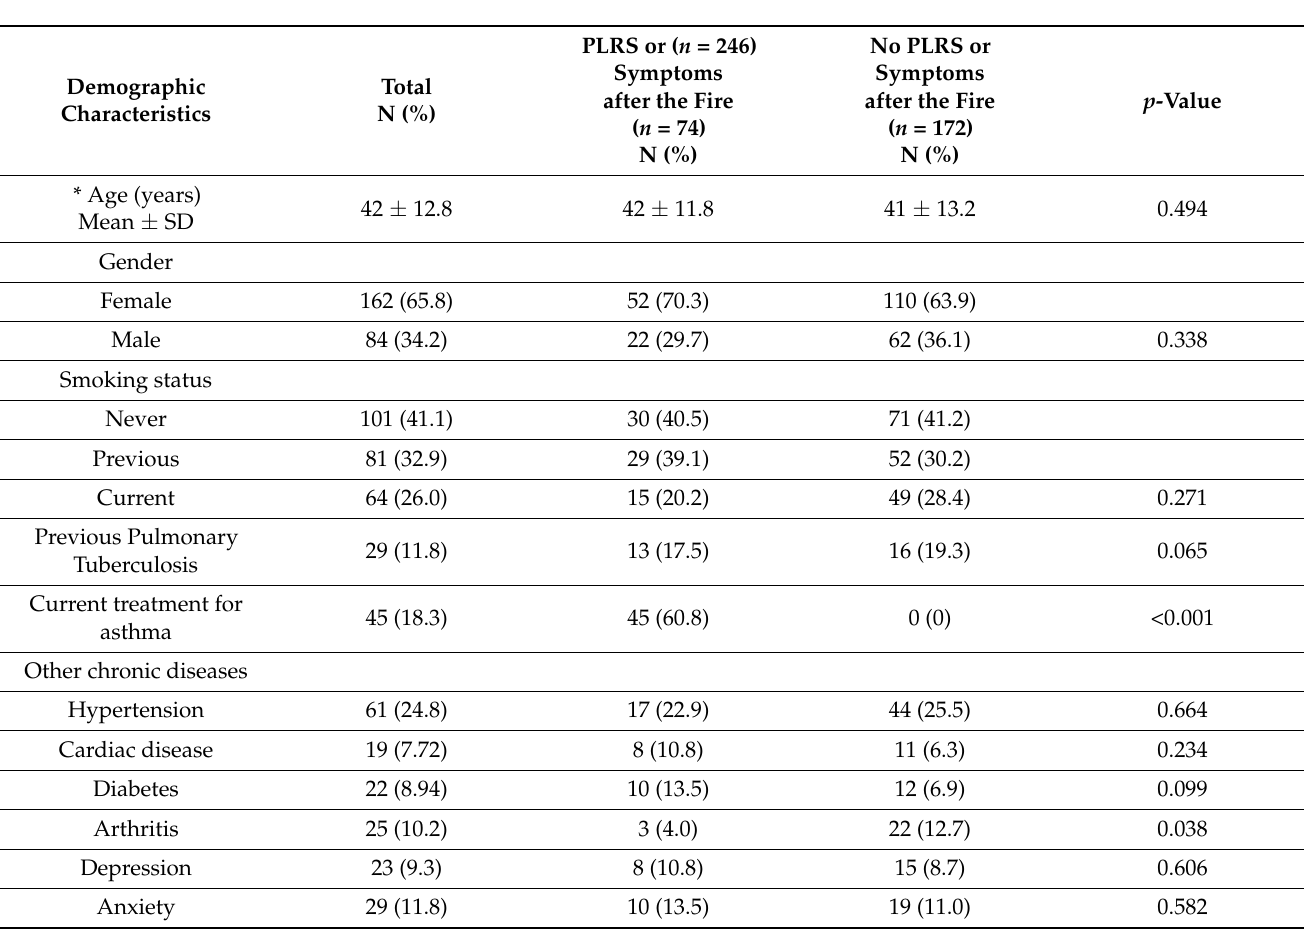
Table 1. Demographic and health-related characteristics of Macassar residents stratified according to the presence of persistent lower respiratory symptoms and/or asthma 6 years after the fire incident ( n =